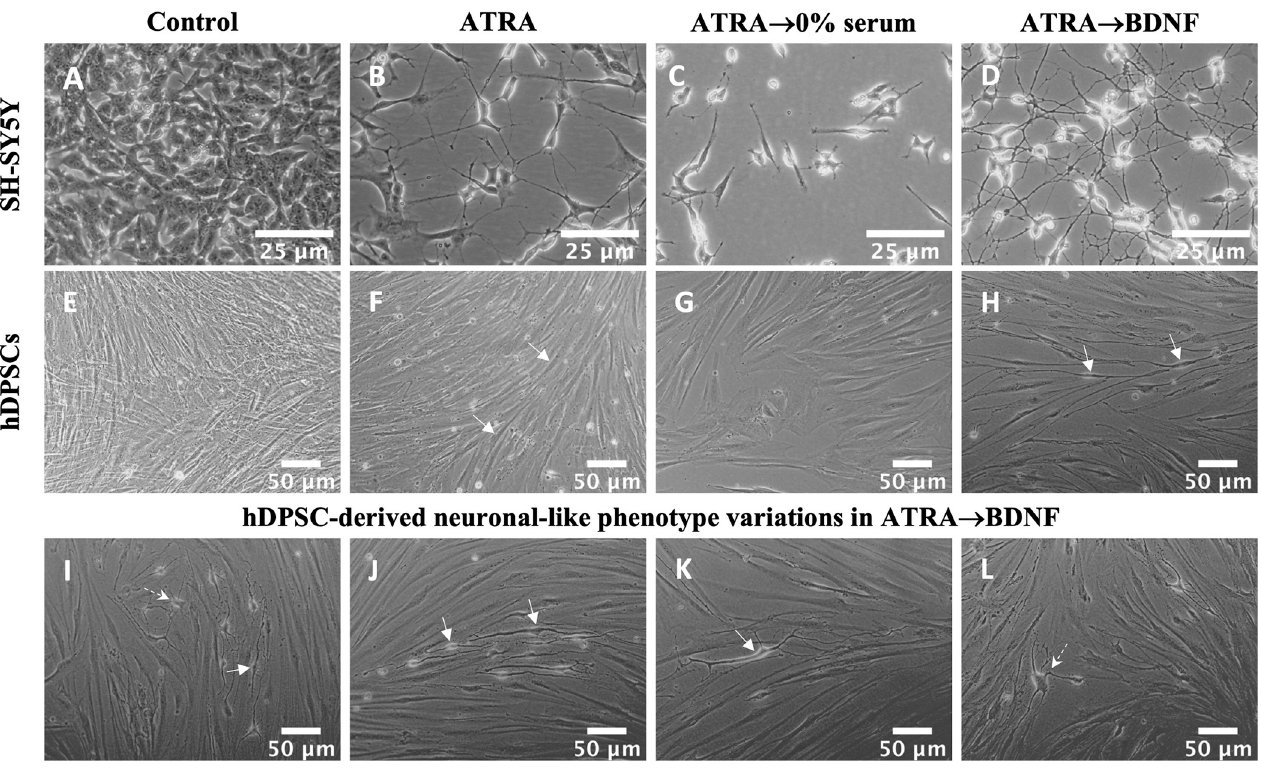
Fig 1. Neural differentiation of SH-SY5Y and hDPSC experimental groups. (A-D) Phase contrast images of SH-SY5Y groups; (A) control, (B) ATRA, (C) ATRA ! 0% serum, and (D) ATRA ! BDNF. (E-L) Phase contrast images of hDPSC groups; (E) control, (F) ATRA, (G) ATRA ! 0% serum and (H-L) ATRA ! BDNF. The phase contrast images were background corrected and converted to 8-bit images. Scale bars are shown. Solid arrows indicate bipolar elongation/morphology; dotted arrows indicate multipolar neuronal-like morphology.